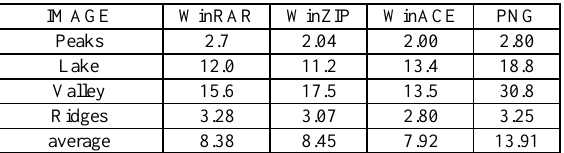
TABLE 3 - Lossless compression ratios from using other standard compression programs as compared to the .PNG In Table 3 the best file compression algorithm, WinRar 3.0, is only able to achieve a compression ratio of 3.79:1. It can also be seen from these results that the .PNG Lossless protocol is able to compress the data more efficiently than winrar, winace and winzip file compression